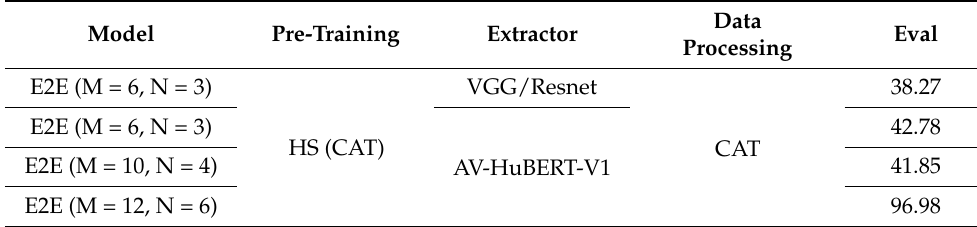
Table 3. The results (CER %) of pre-trained audio–visual representation on the AVSR task. HS means the hybrid system. CAT means splicing the continuous segments. M and N denote the number of blocks in the encoder and decoder modules, respectively. AV-HuBERT-V1 is the utilized modified AV-HuBERT